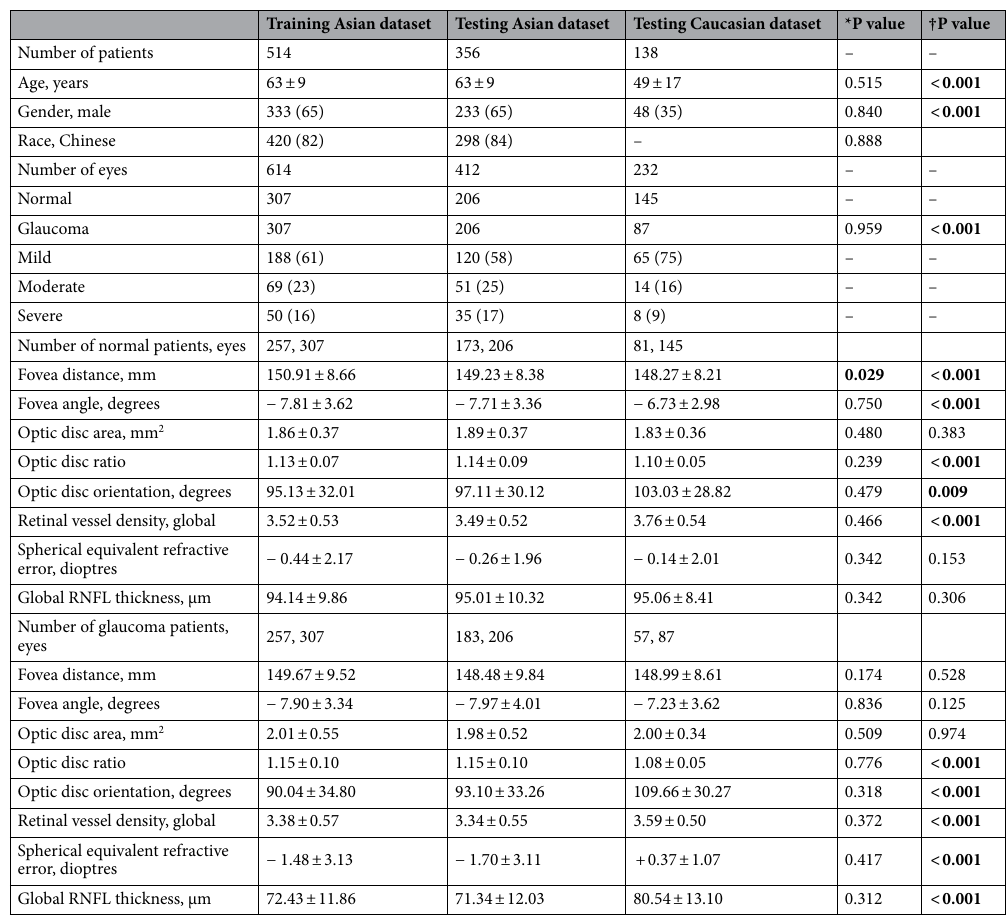
Table 1. Characteristics of the training and testing datasets. Data are number, mean ± standard deviation, or number (%). For n (%), the denominator is number of patients or number of eyes (by eye), as applicable. P value was obtained with independent t-tests for continuous variables and with chi-square tests for categorical variables and values in bold indicate statistical significance. * Denotes comparison between Asian training and Asian test dataset whereas † between Asian training and Caucasian test dataset.